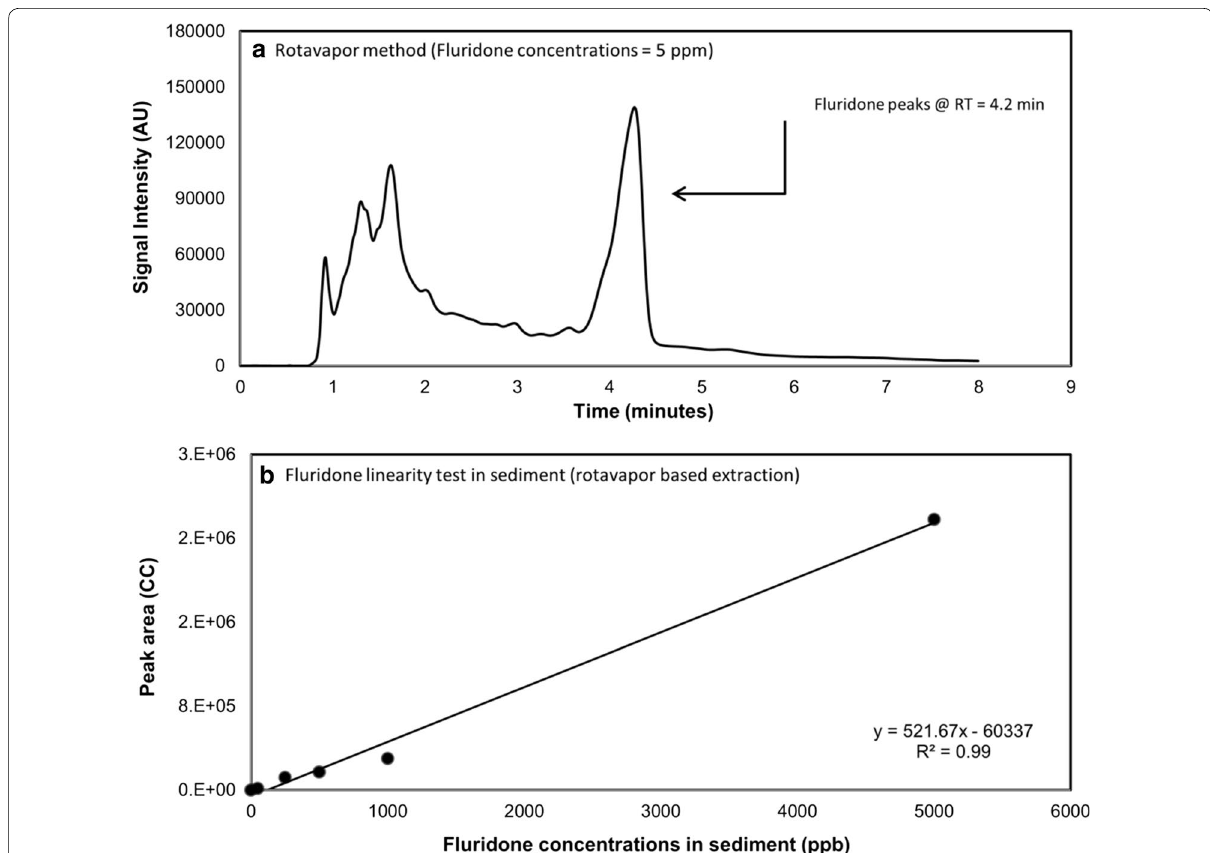
Fig. 2 Fluridone detection in sediment samples using rotavapor method (RM): a fluridone peak in sediment sample at 5 ppm; and b relationship between fluridone concentrations in sediment and peak